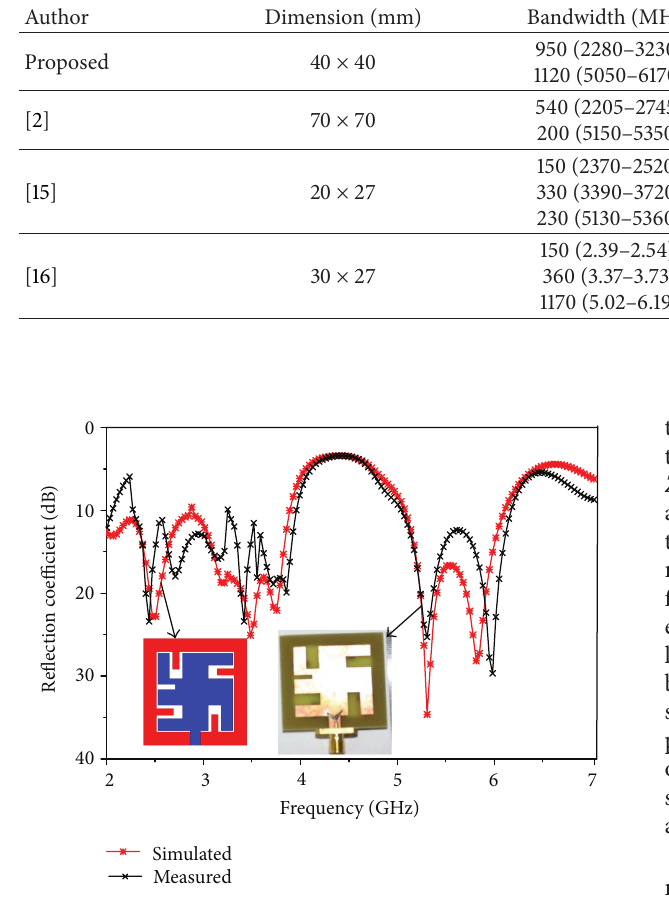
Figure 13: Comparison between simulated and measured reflection coefficient of the proposed